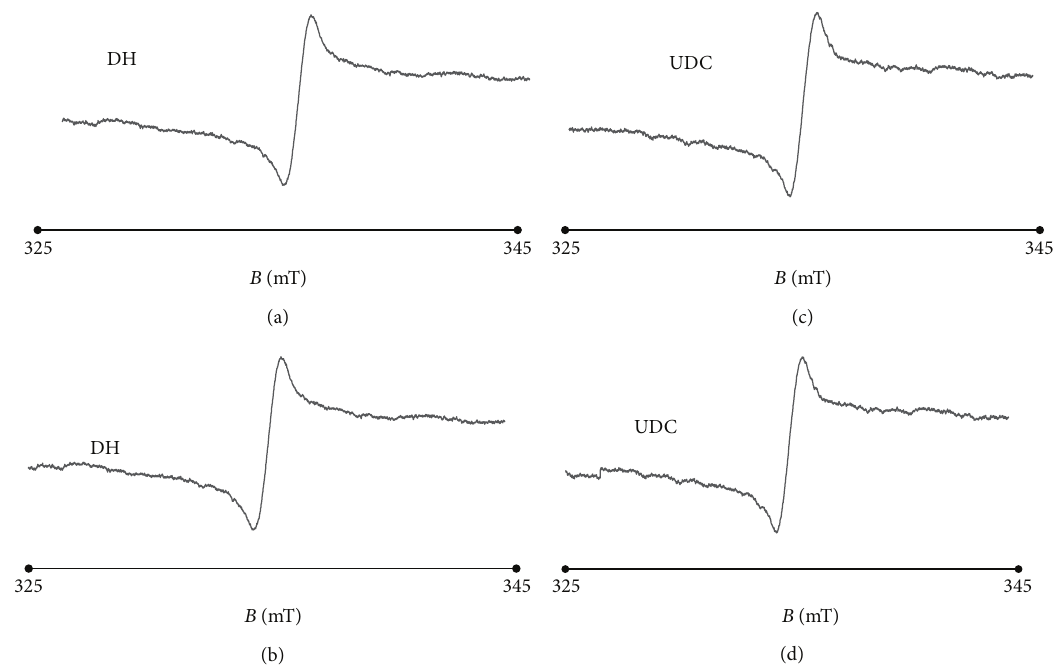
Figure 3: EPR spectra of DH and UDC (UV irradiated) during 30 minutes (a), (c) and also during 60 minutes (b) and (d).